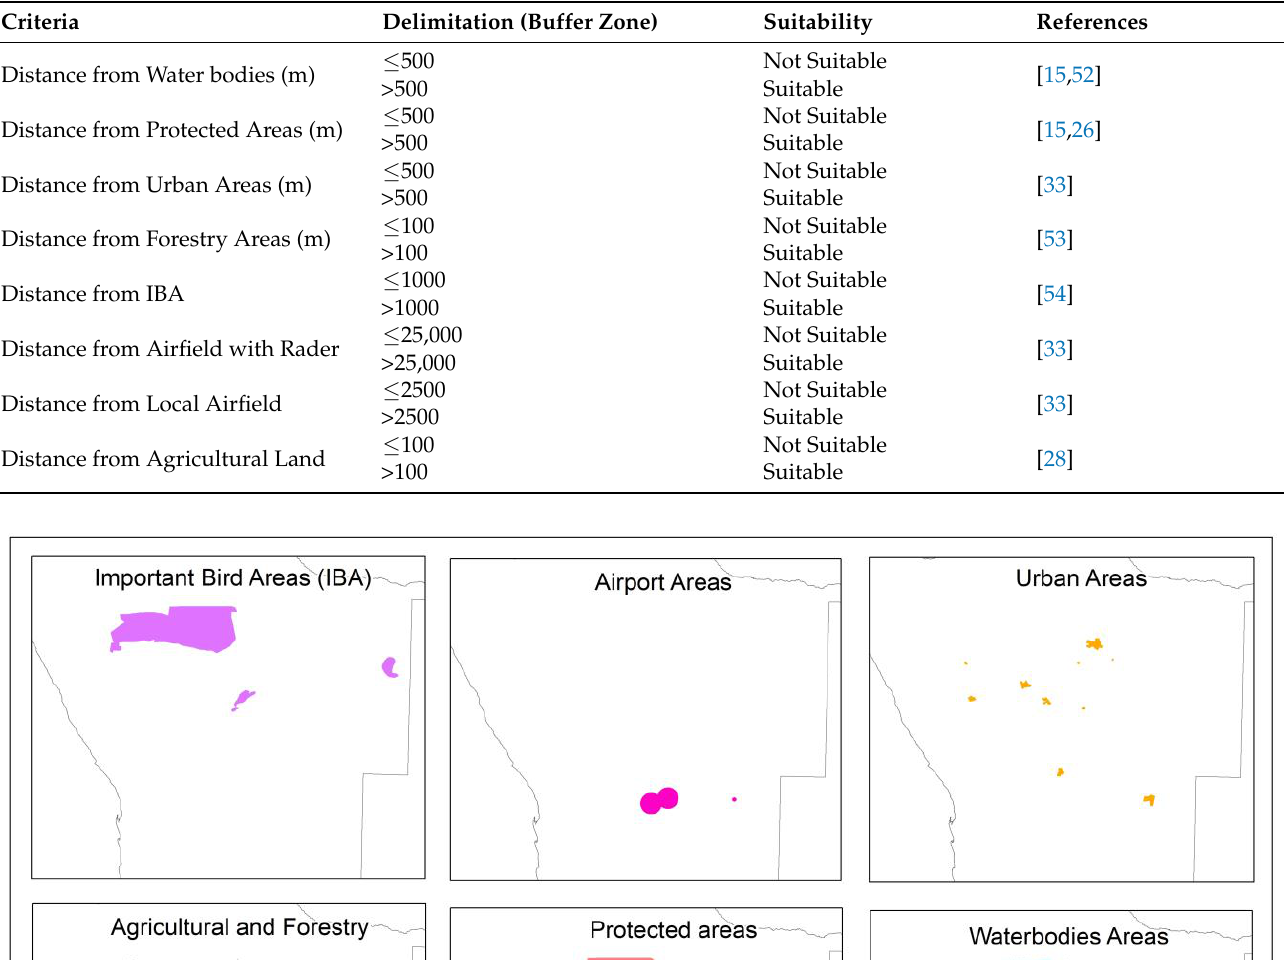
Table 4. Constraints involved in installing solar PV and wind power plants.